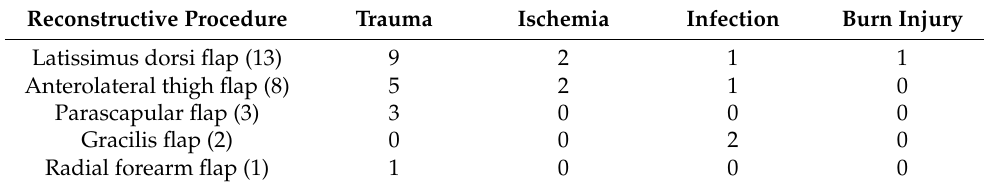
Table 2. Type of reconstructive procedure and etiology of